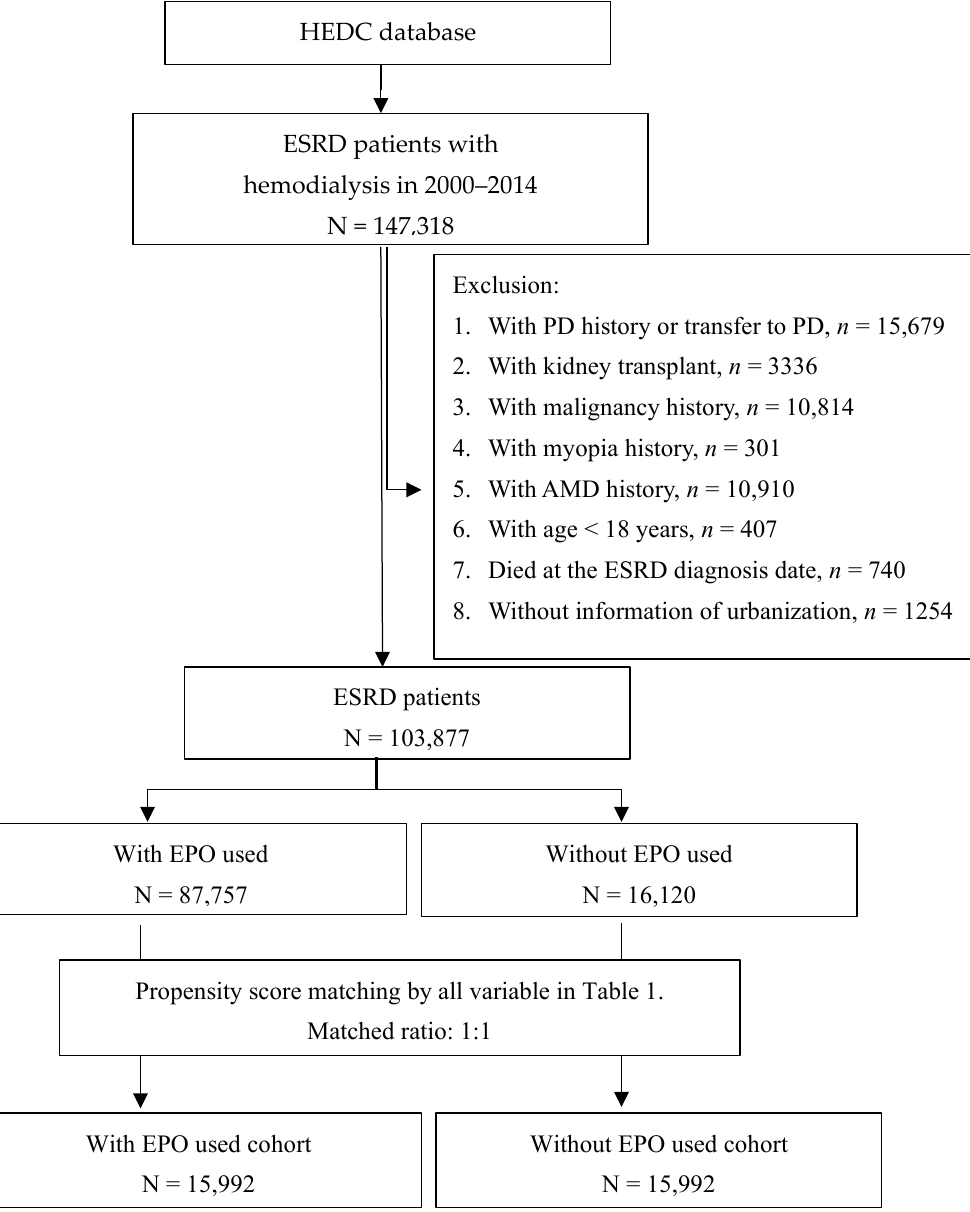
Figure 2. Flow chart of study cohort